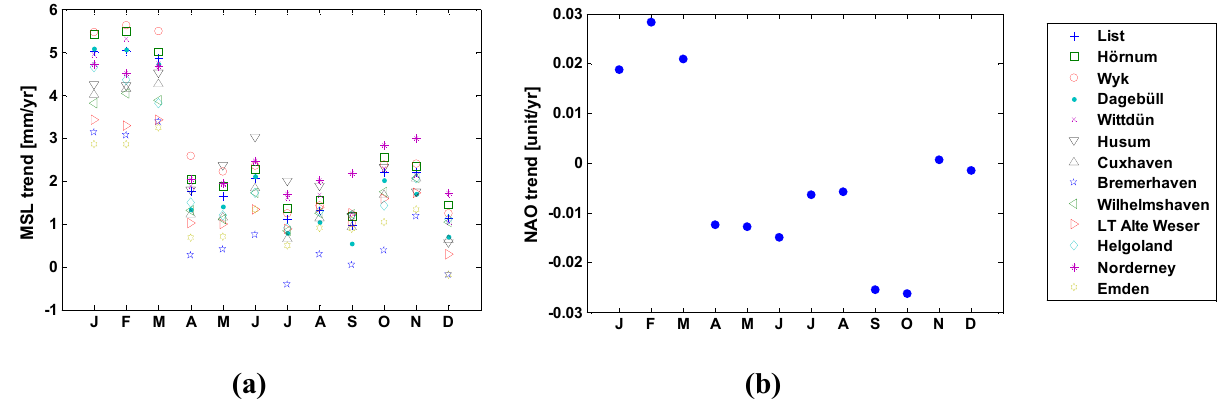
Figure 6. Inter-annual trends of monthly MSL ( a ) and monthly NAO ( b ) for the period from 1951 to 2008.